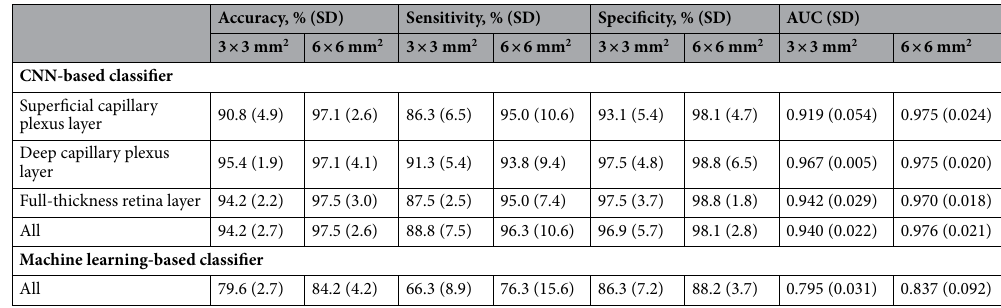
Table 3. Performance of classification task for detecting referable status of diabetic retinopathy using the proposed deep learning- and machine learning-based classifiers. AUC area under the curve, CNN convolutional neural network, SD standard